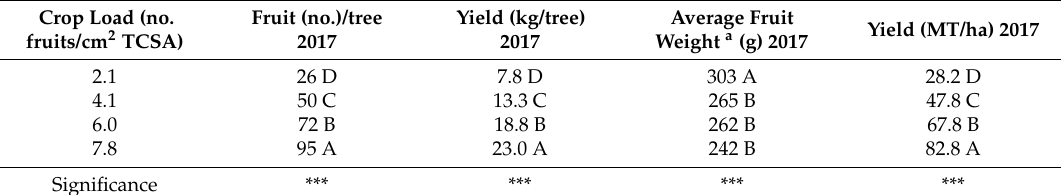
Table 1. The effects of crop load on the number (no.) of apples/tree, yield (kg/tree), average fruit weight (g), and production (MT/ha) for “WA38” apples grown in Washington State, Wenatchee area in 2017. TCSA—trunk cross-sectional area.